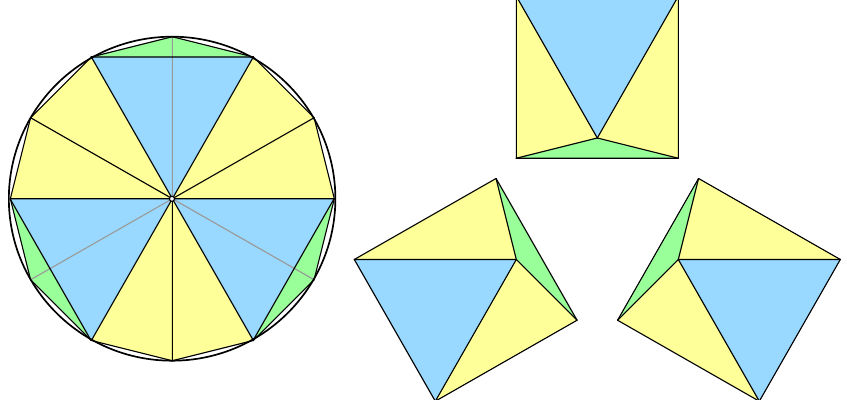
Figure 6: Proof without words: the area of a regular dodecagon inscribed in a unit circle is 3. © Mathematical Association of America, 2015. All rights